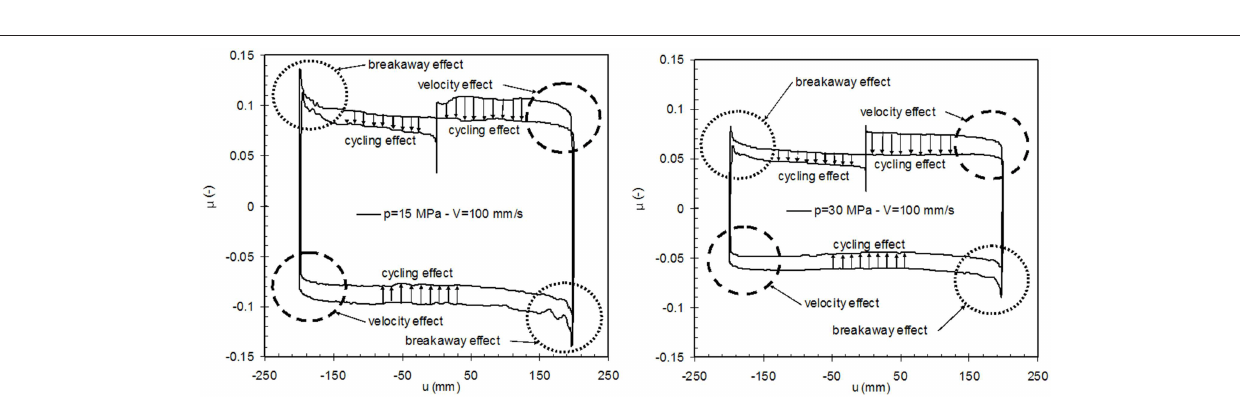
FIGURE 2 | Variability of friction coefficient with pressure, velocity, and cyclic effects (from Lomiento et al.,